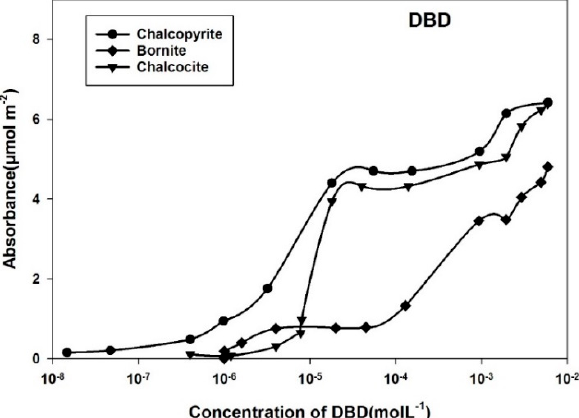
Figure 13. The adsorption of dithiophosphate from a mixture of xanthate and dithiophosphate on the copper sulphide surface at pH 8.